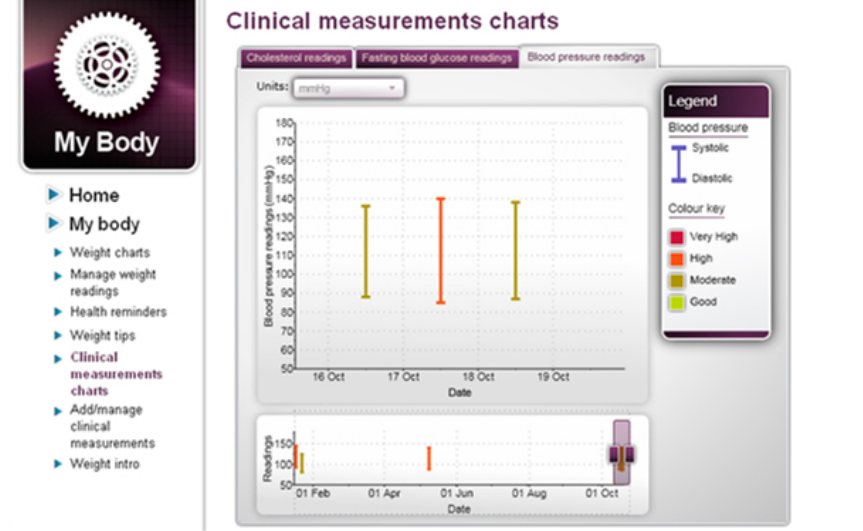
Figure 3. Imperative Health screenshot of clinical measurement feedback